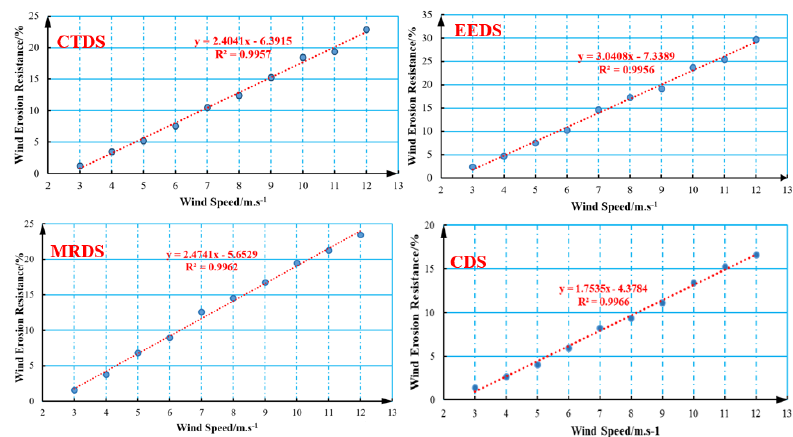
Figure 11. Linear fitting diagram of wind erosion resistance data of four dust suppressors. Through the measurement of viscosity and anti-wind erosion, the performance and dust suppression effect of the four tested dust suppressants can be comprehensively compared. CDS had pollution.